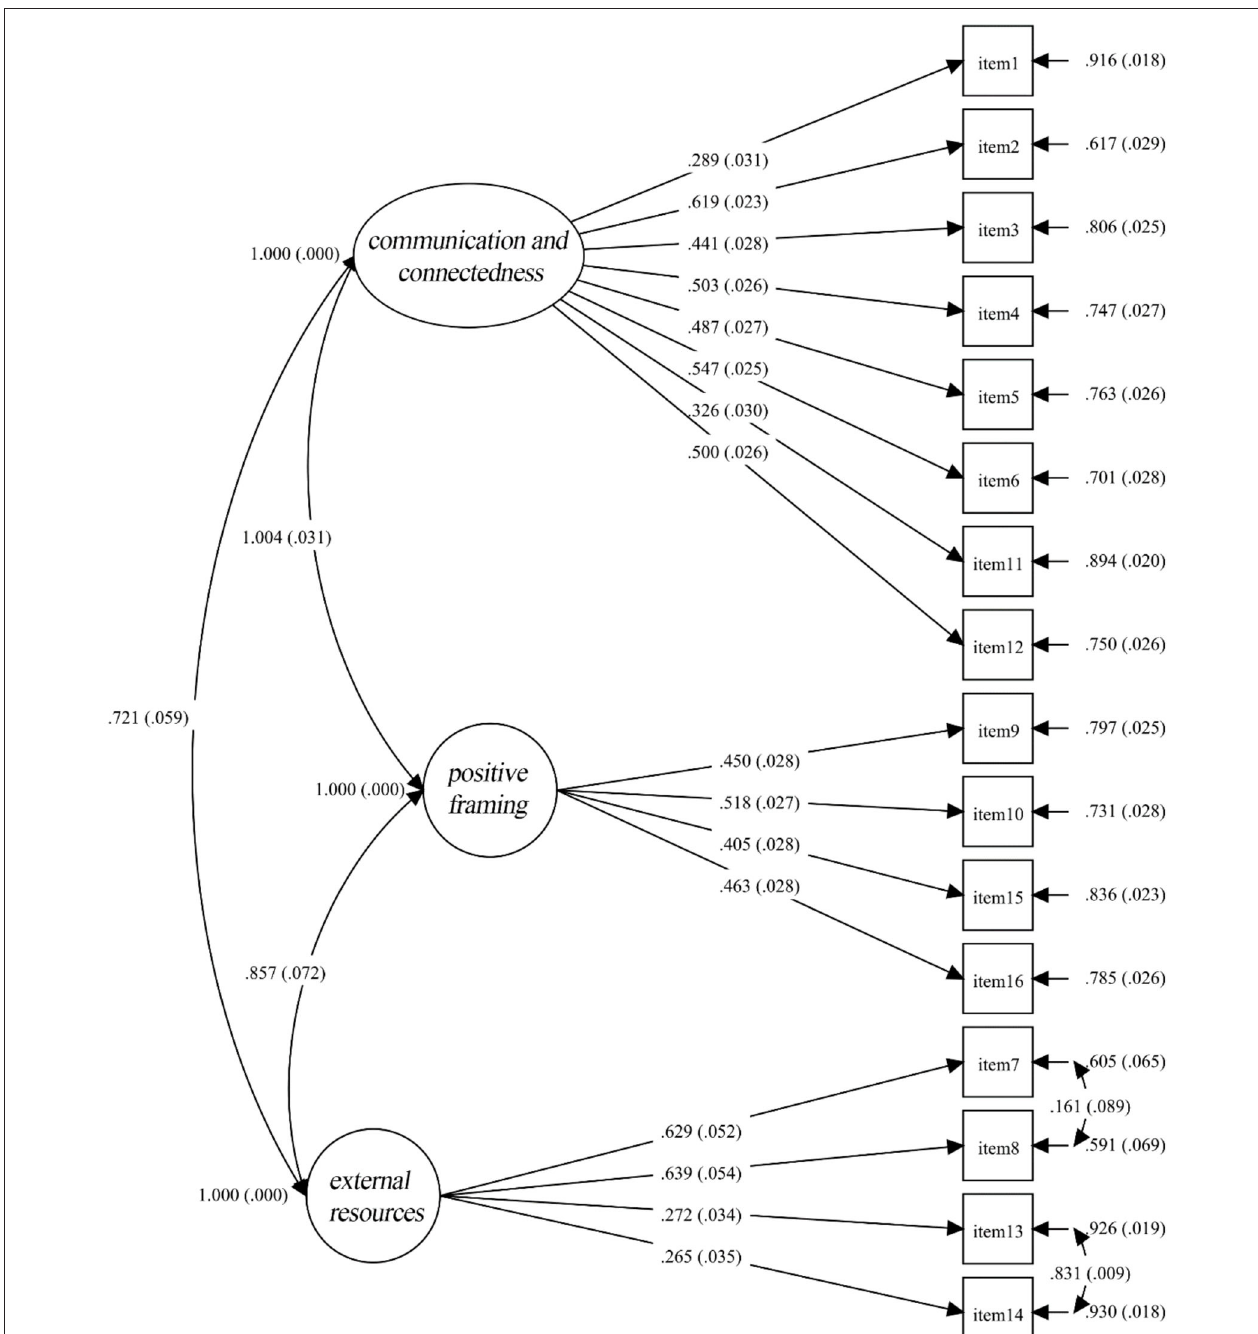
FIGURE 2 | Factor structure and standardized factor loadings of